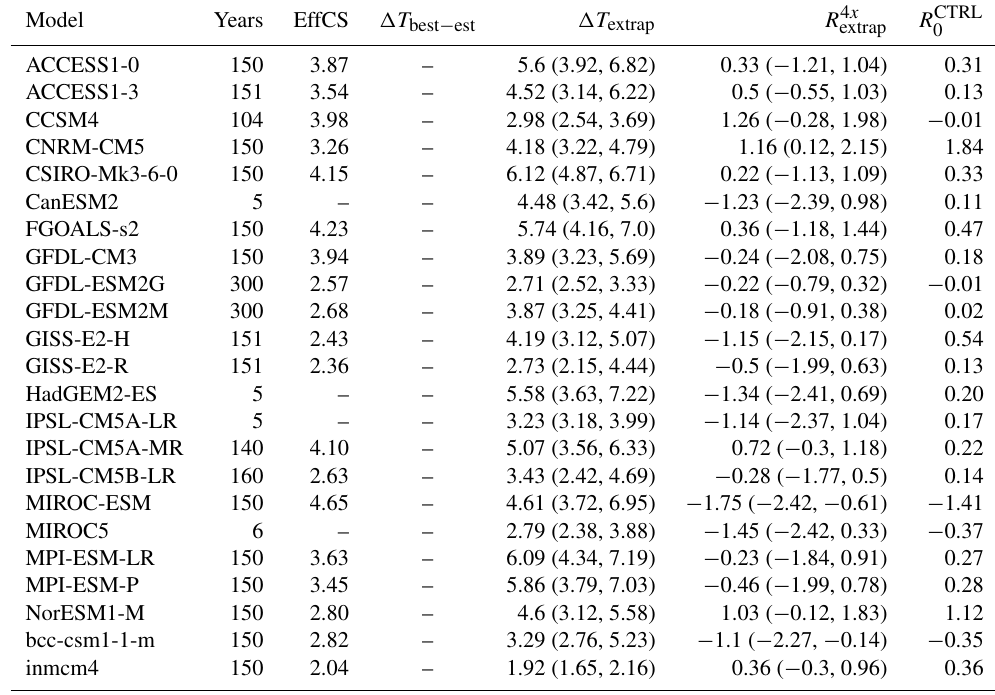
Table A2. Fitted parameters and uncertainties for the CMIP5 experiments.